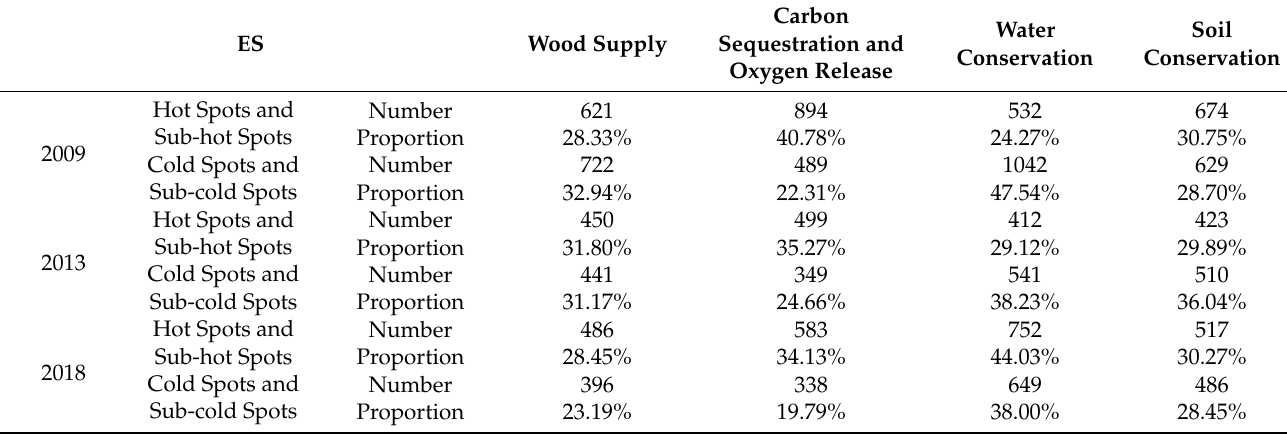
Table 2. Statistics on the number of small classes of cold hot spots of ESs in PM plantations in Guangxi Paiyangshan Forest Farm in